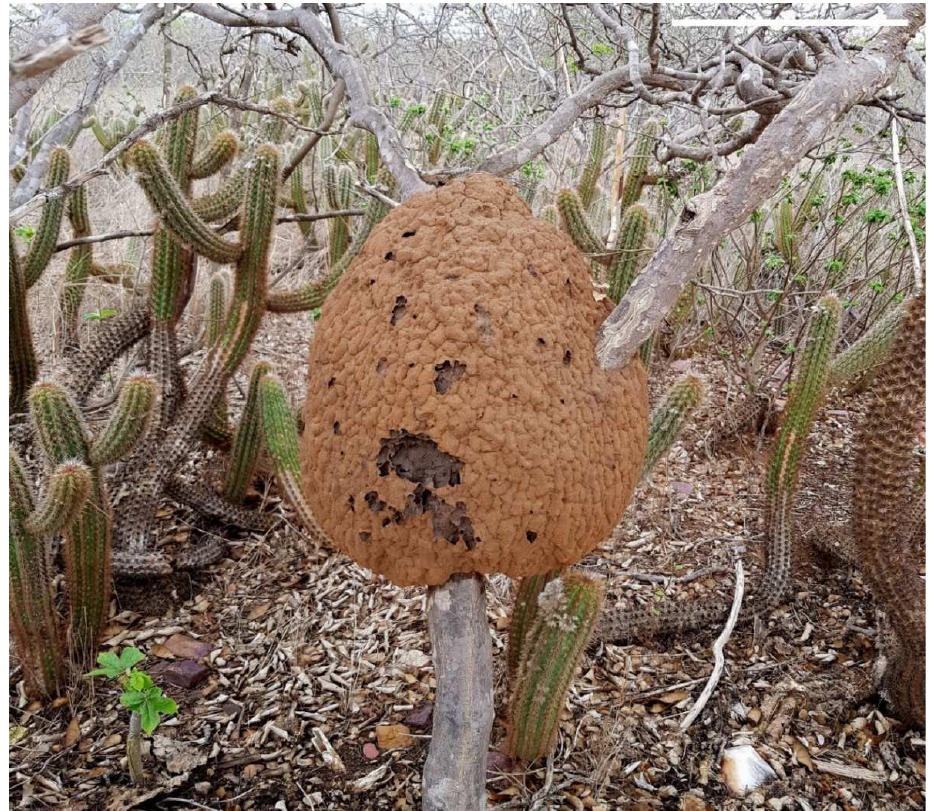
Figure 1. Nest of Constrictotermes cyphergaster (Blattodea, Termitidae) in a Caatinga forest, Northeastern, Brazil. Scale bar on top right = 30 cm.